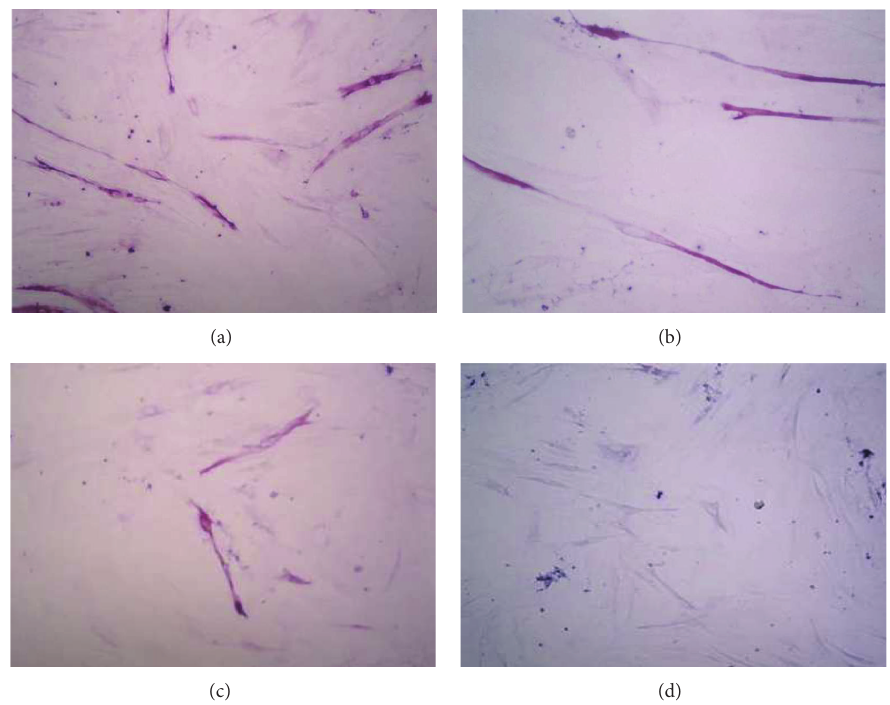
Figure 6: Expression of myosin in myoblasts in response to LPLI. The cells were treated and grouped as described above and expressions of myosin were determined 48h after irradiation by immunohistochemistry. (a), (b), (c), and (d) were from control, laser irradiation for 3 min, 10% FBS, and 20% FBS group,